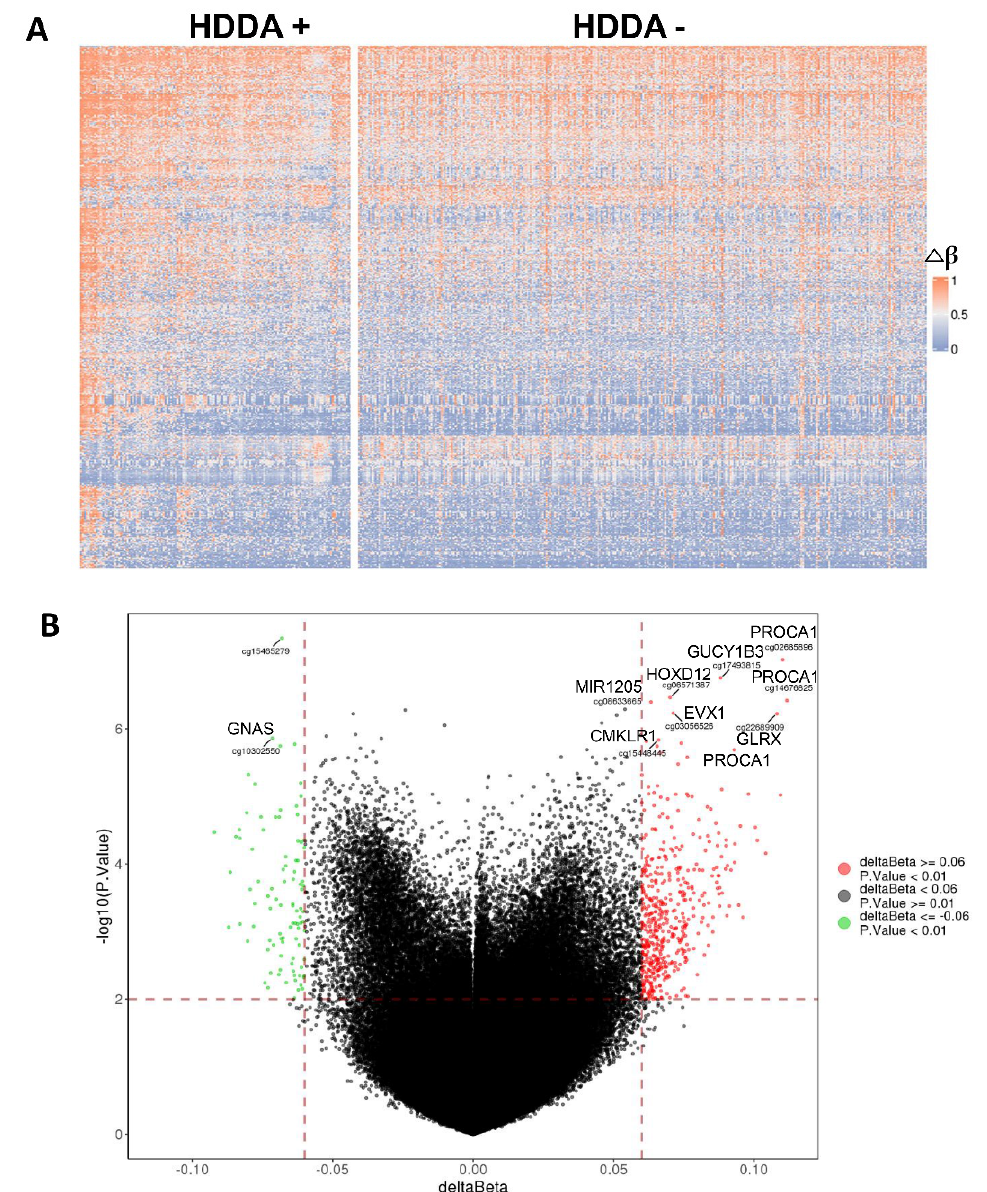
Figure 3. Differentially methylated probes (DMPs) between TC tumors with and without HDDA. ( A ) The heatmap of DMPs in tumors with and without HDDA based on 309 DMPs in the Table S2. DMPs with | Δβ | > 0.06 and adjusted p < 0.05 were included. The scale is from 0 (blue) to 1 (red). ( B ) The volcano image showing the most significant DMPs and genes where they reside. Green dots: significantly hypomethylated probes (57) in HDDA tumors, and red dots: significantly hypermethylated probes (252) in HDDA tumors (compared to tumors without HDDA).